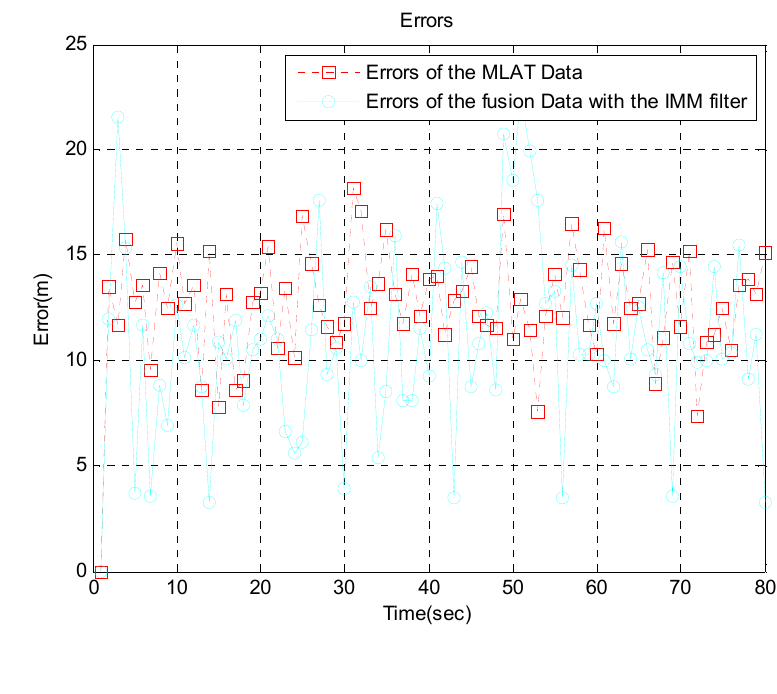
Figure 9. Errors between MLAT data and fusion data with the IMM filter at 16 km from the airport.